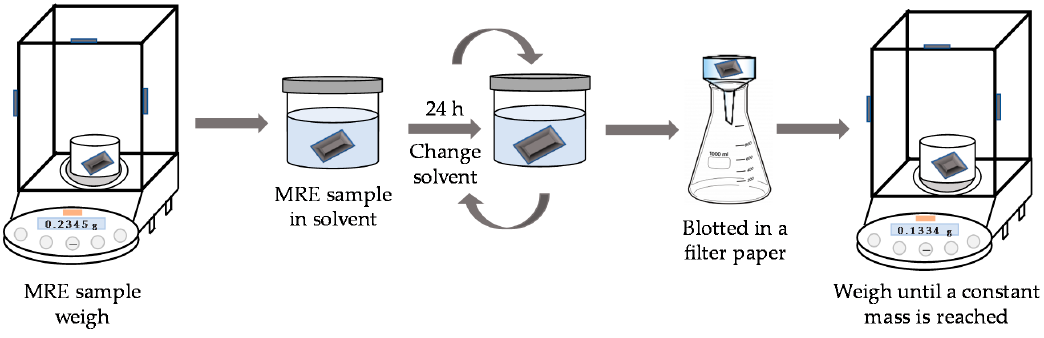
Figure 2. Schematic representation of swelling test procedure.